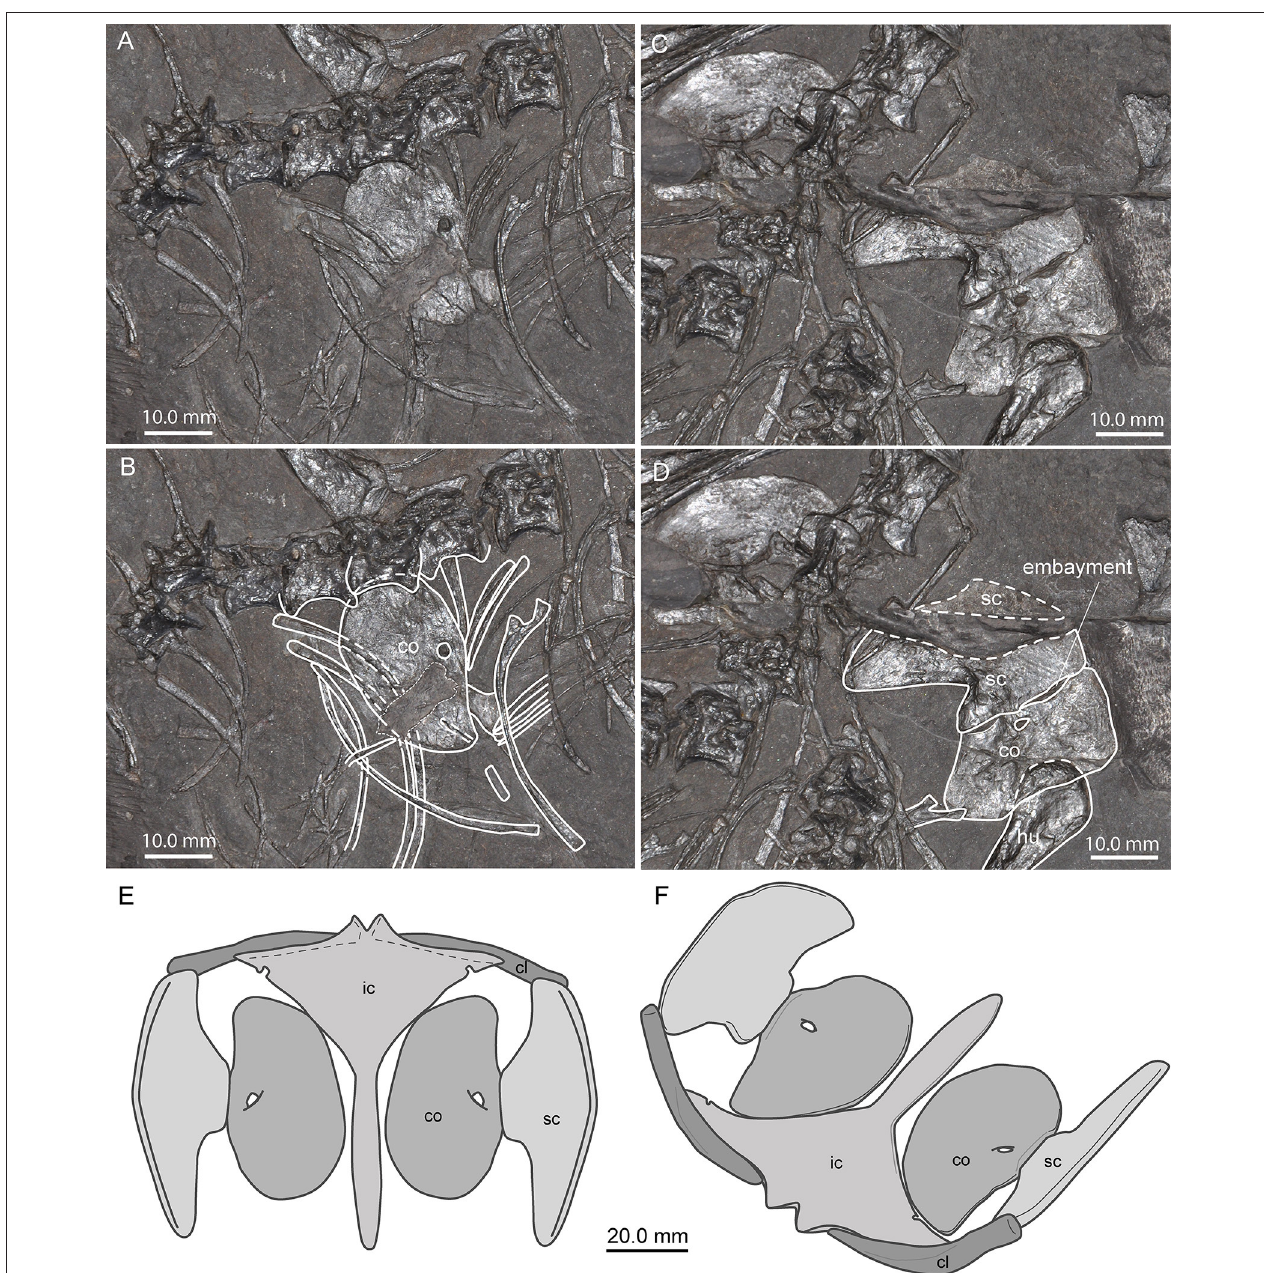
FIGURE 11 | Coracoid and scapula shape and pectoral girdle reconstruction of Macrocnemus . (A,B) Close-up view and interpretative drawing of the left coracoid and adjacent axial bones in PIMUZ T 2472. Note that the element indicated by an asterisk (*) is not interpreted as part of the coracoid, but constitutes part of an underlying bone. The area framed by the thin stippled line is reconstructed. (C,D) Close-up view and interpretative drawing of the right articulated scapula and coracoid, showing only a slit-like embayment due to partial overlap and distortion of the bones. (E,F) Inferred pectoral girdle reconstruction based on the well-preserved elements of PIMUZ T 1559 in dorsal (E) and angled anterior view (F) . Note that the small circular emarginations in the posterior margins of the wing-like lateral processes are present only in PIMUZ T 1559.